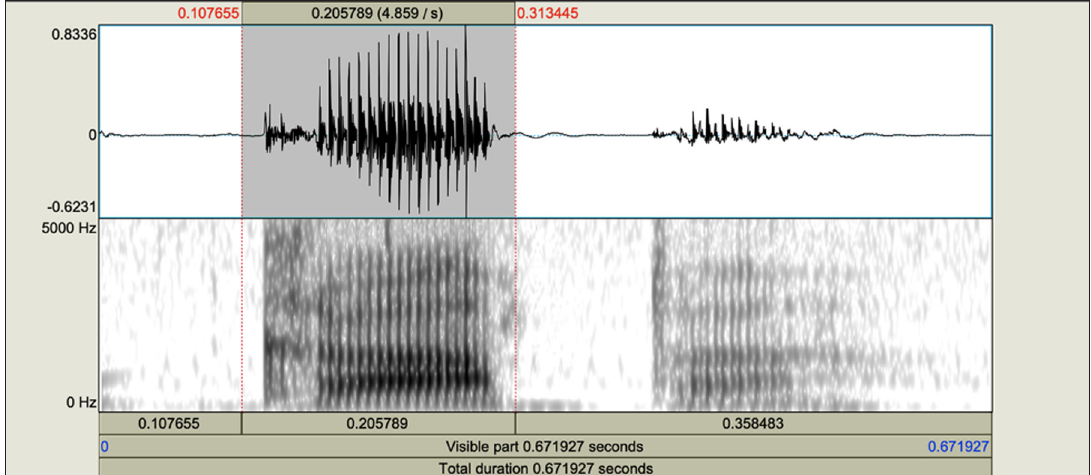
Figure 1: Waveform and broadband spectrogram for speaker 1 production of capa . The high- lighted portion corresponds to the consonant [k] and vowel